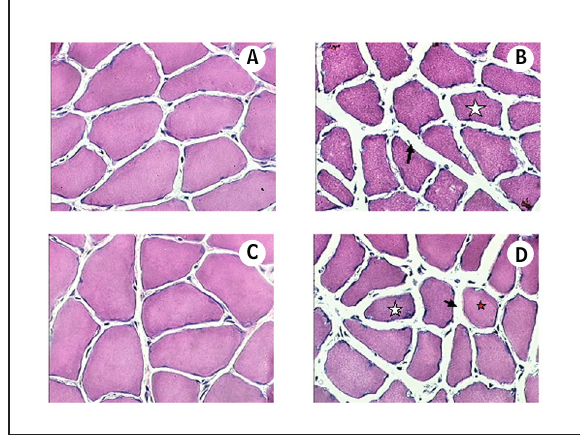
Figure 1 - Photomicroscopes of transverse sections of the middle third from the soleus